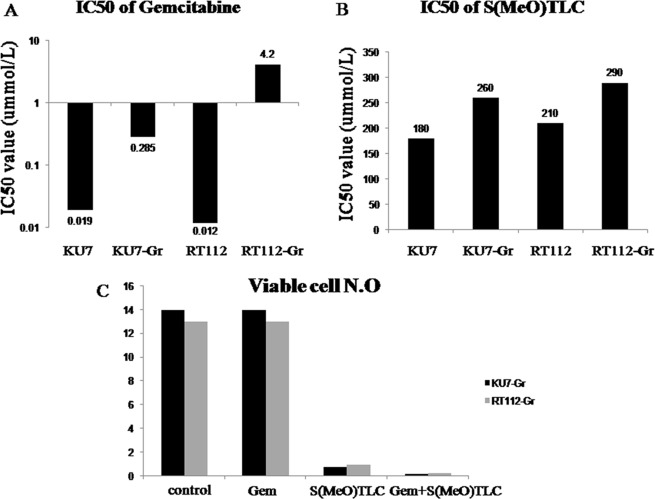
S(MeO)TLC overcomes Gemcitabine resistance.A: The IC50s of Gemcitabine in KU7、KU7-Gr、RT112 and RT112-Gr in 72 hours. B: The IC50s of S(MeO)TLC of KU7、KU7-Gr、RT112 and RT112-Gr in 72 hours. C: KU7-Gr and RT112-Gr cells were left untreated or were treated with 45nM Gemcitabine (GEM), 0.5μM S(MeO)TLC or both together (GEM+ S(MeO)TLC). Seventy-two hours later viability was analyzed by Trypan blue staining. S(MeO)TLC and GEM+ S(MeO)TLC, inhibiting tumor effect is the best among the four group. Quantification of each value is from triplicate independent experiments. (p < 0.01).